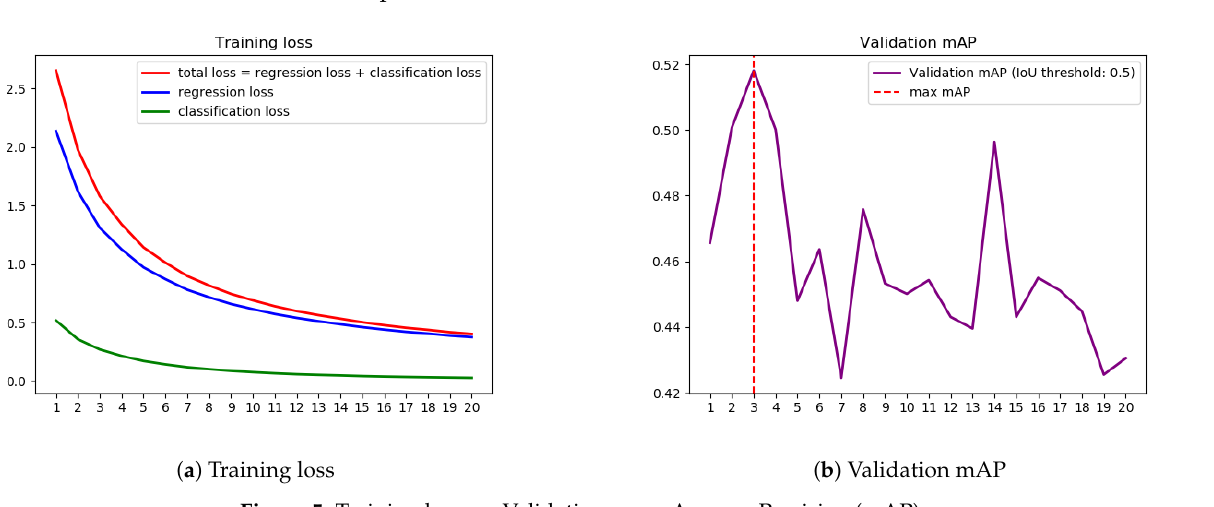
Figure 5. Training loss vs. Validation mean Average Precision (mAP).